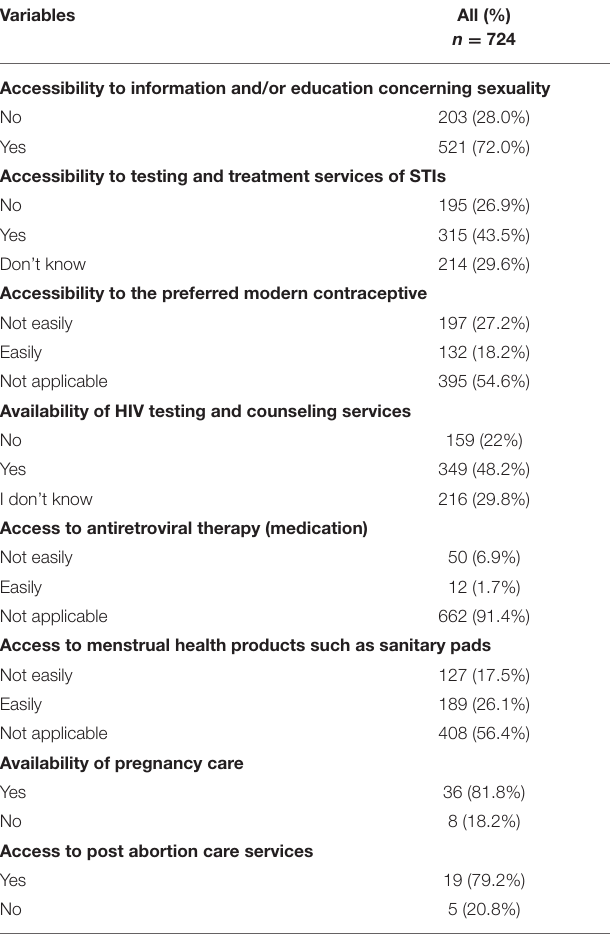
TABLE 1 | Socio-demographic characteristics of study participants. TABLE 2 | Access to sexual and reproductive health services among Ugandan youth during the COVID-19 lockdown.